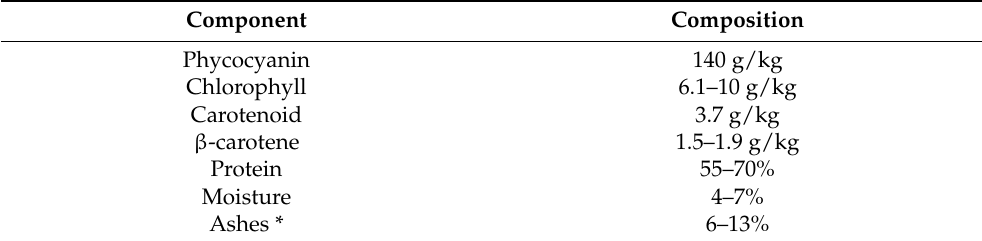
Note(s): * Ashes: inorganic residue after ignition at 550 ◦ C for 1